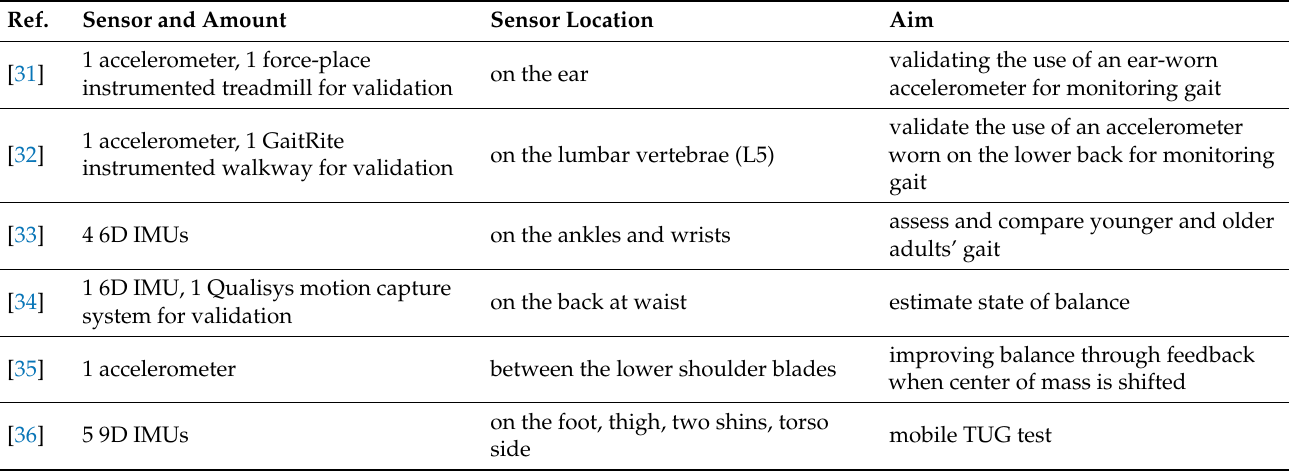
Table 2. Study characteristics for studies on gait and